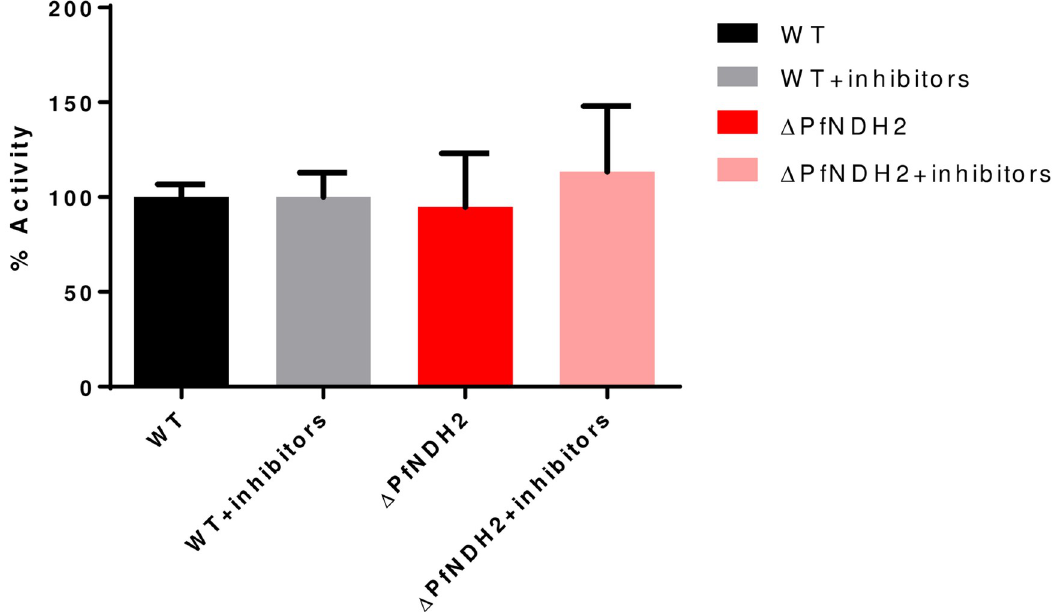
Fig 5. NADH-linked cytochrome c reductase activity in the in vitro assay is not dependent on PfNDH2 or mtETC. In each measurement, 25 μ g of mitochondrial sample was used. Rates of cytochrome reduction were measured without and with addition of a mix of bc 1 inhibitors, including atovaquone (62 nM), ELQ-300 (62 nM) and HDQ (3,100 nM). The concentrations of these inhibitors were equal or greater than 100 times of their individual EC 50 values. Data shown is mean ± s.d. of n = 3